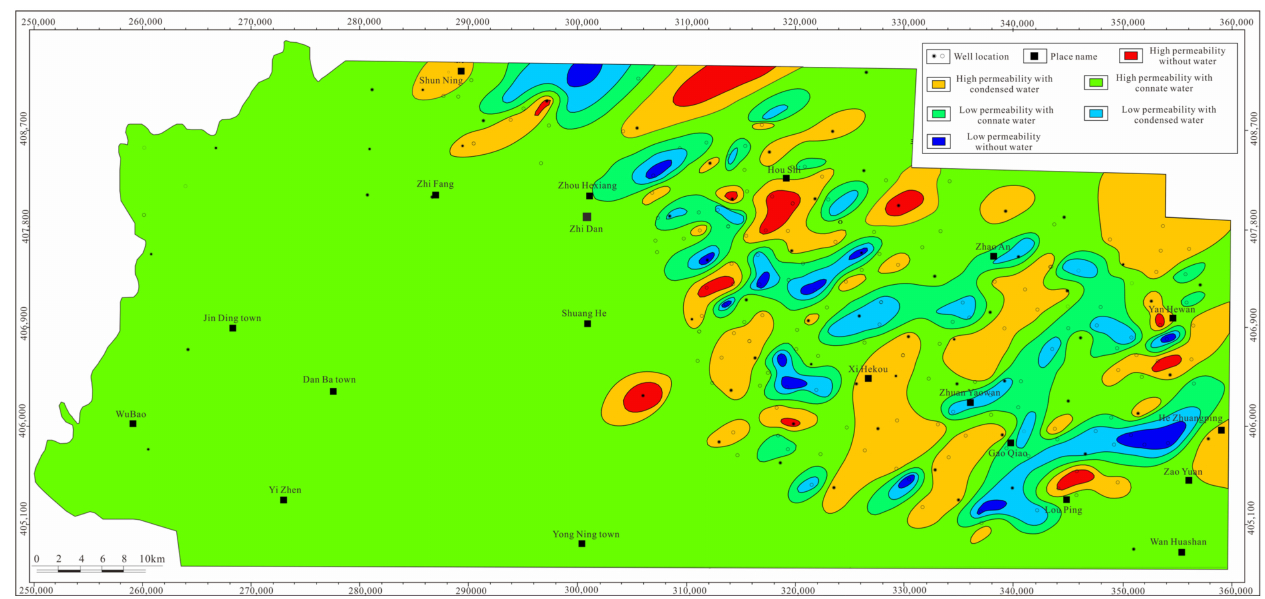
Figure 7. Distribution map of permeable formation bodies in Gaoqiao area, Ordos